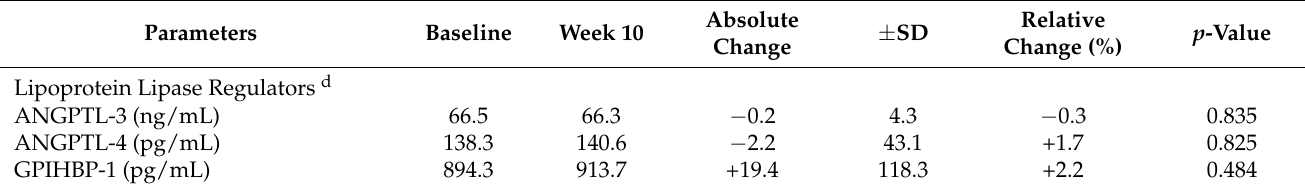
Legend: Table shows mean values and changes; Trial completion analysis ( n = 19); Paired t -test with two-sided